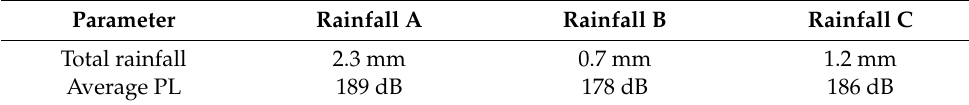
Table 6. The parameters of the additional experiment results during